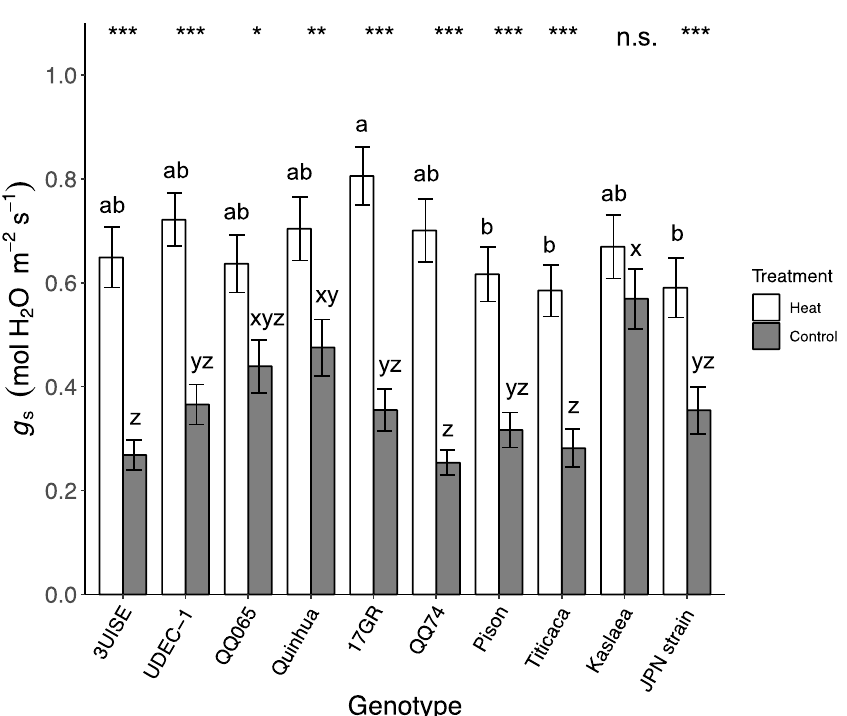
Figure 2. Stomatal conductance (g s ; mol H 2 O m −2 s −1 ) of 10 quinoa genotypes exposed to a four-day heat treatment (45 °C/30 °C) and control treatment (20 °C/14 °C); day and night, respectively. Values are means ± SE ( n = 32). Mean comparisons are shown for within genotype (asterisks and n.s.) and within temperature treatment (Heat: a to b; Control: x to z); different letters are significantly different at p < 0.05; *, p < 0.05; **, p < 0.01; ***, p < 0.001; n.s., not significantly different.